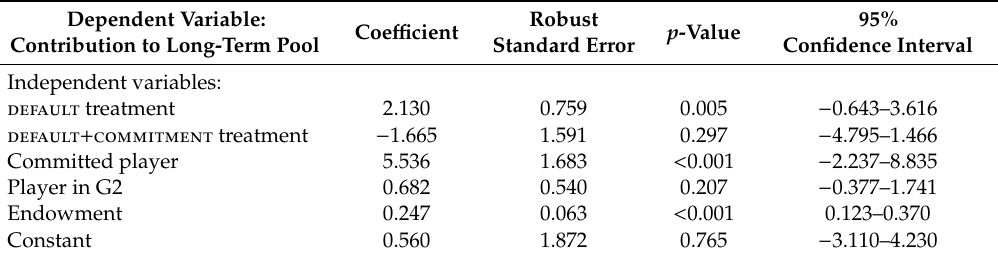
Table 1. Multi-level mixed e ff ects regressions predicting contributions to the long-term